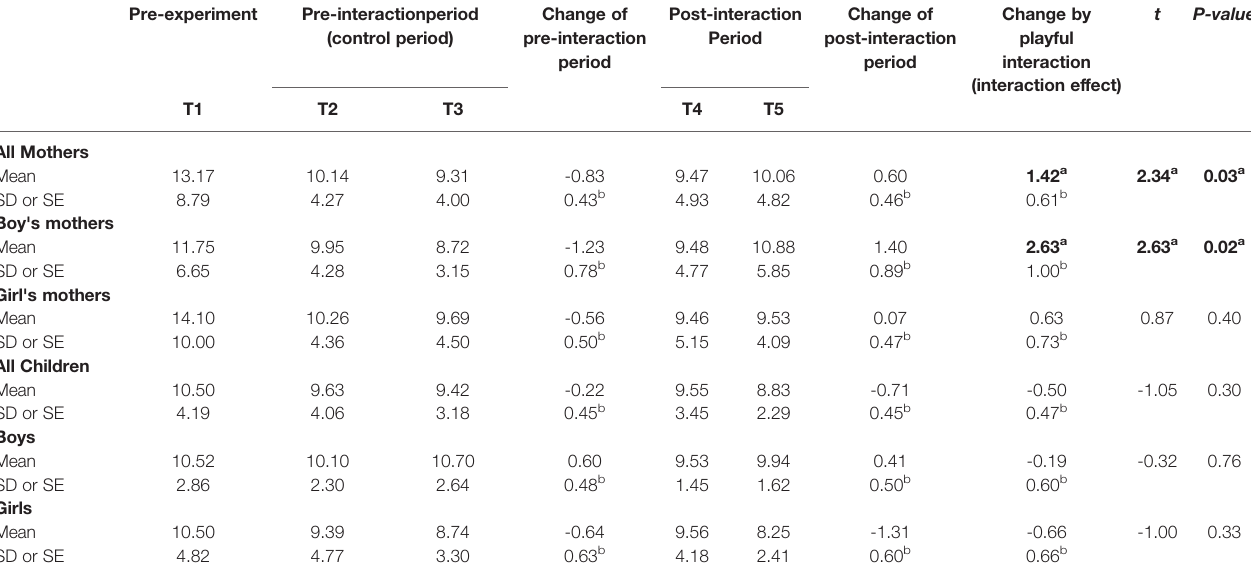
TABLE 2 | Mean oxytocin level of mothers and children at each time